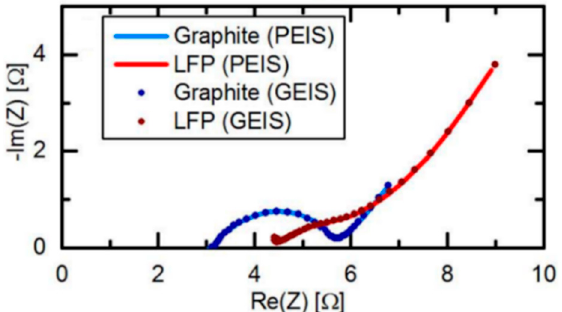
Figure 7. Comparison of the impedance response (100 kHz–0.1 Hz) of graphite and LiFePO 4 electrodes using potentiostatic electrochemical impedance spectroscopy (PEIS) (5 mV amplitude, straight lines) and galvanostatic electrochemical impedance spectroscopy (GEIS) (0.5 mA amplitude, dotted lines). Reproduced with permission from [73] .